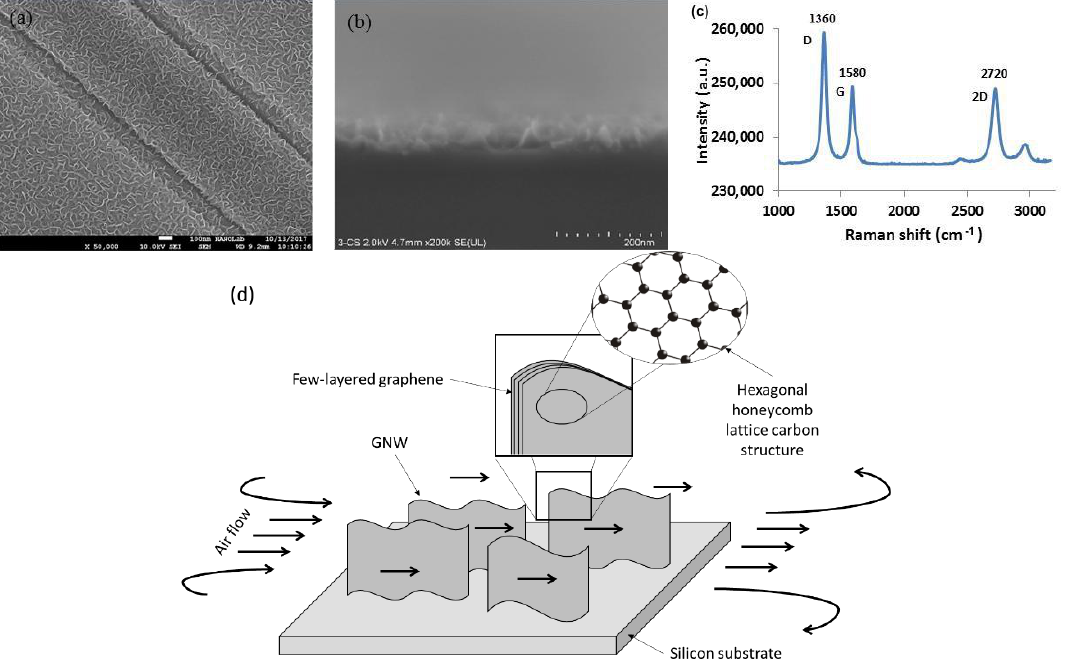
Figure 2. FESEM images of the ( a ) top view of graphene nanowall (GNW) on silicon trench, ( b ) cross-section of the GNW, ( c ) Raman spectrum of the GNW showing D, G and 2D peaks, and ( d ) illustration diagram of GNW on silicon substrate that have an ultra-large surface contact with the air.